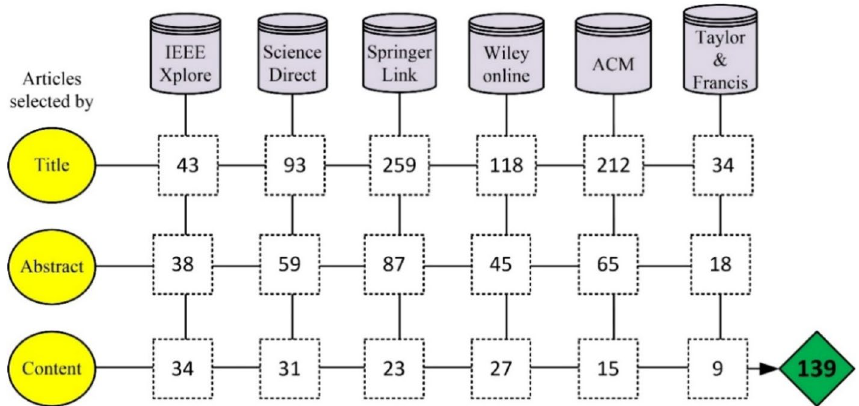
Figure 4. Distribution of primary studies.